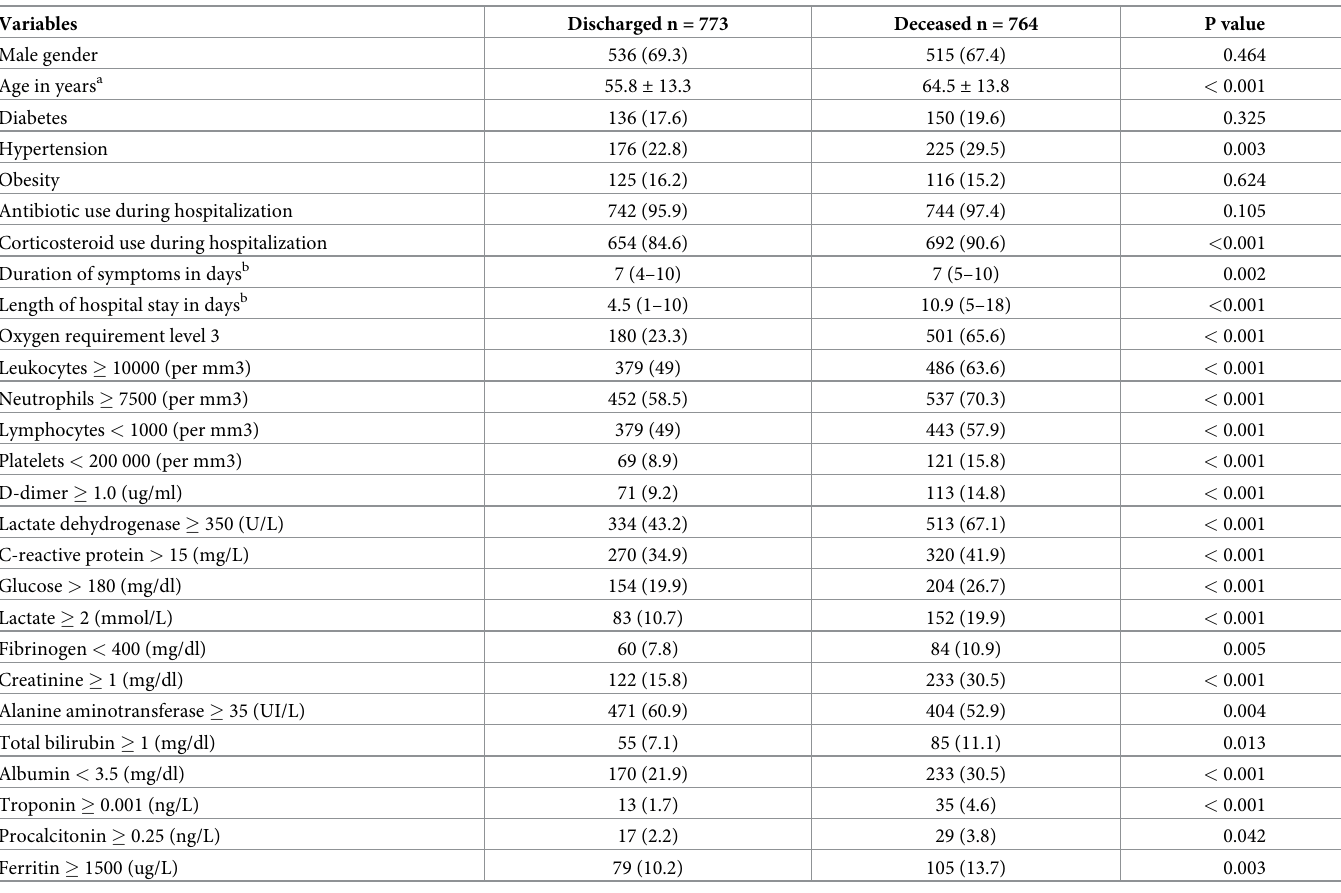
Table 2. Association between mortality and main